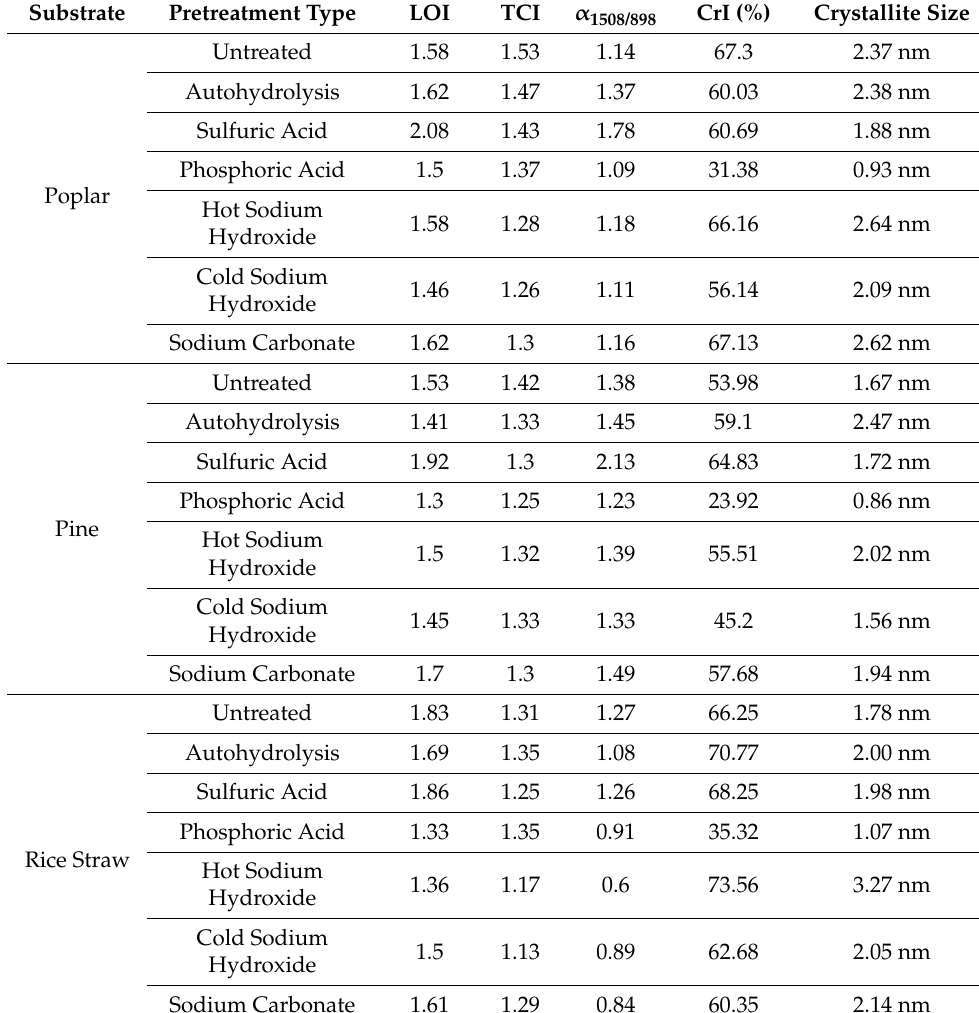
Table 2. TCI, LOI, and lignin to cellulose ratio based on FTIR, and CrI, and crystallite size based on XRD spectra of untreated and pretreated